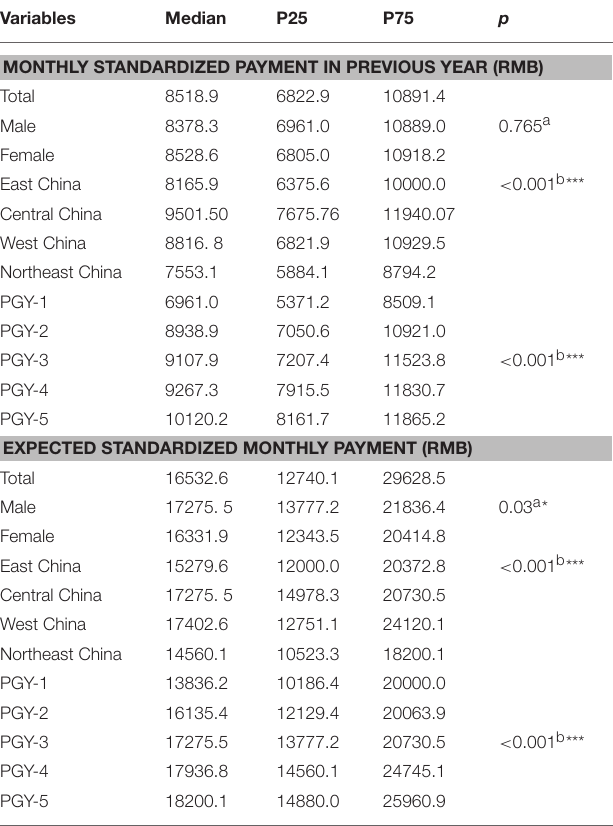
TABLE 2 | Monthly standardized pay and expected standardized pay of psychiatrists ( N = 1,060).